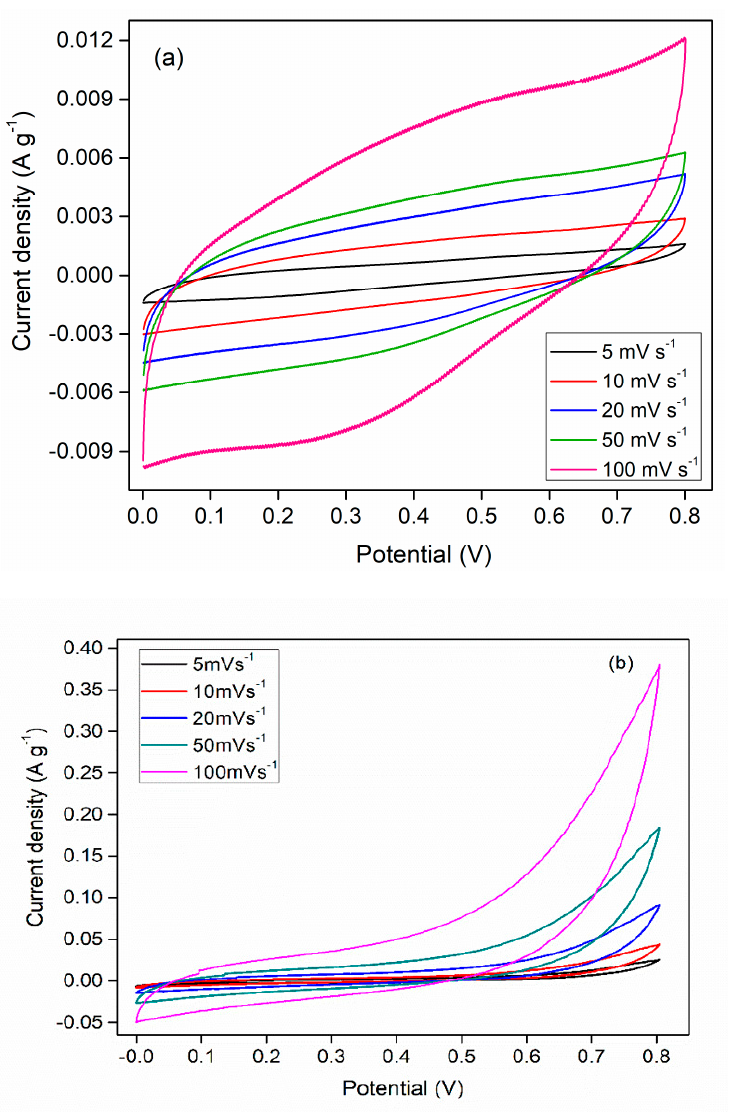
Figure 4. CV profile of ( a ) TiO 2 and ( b ) rGO/TiO 2.